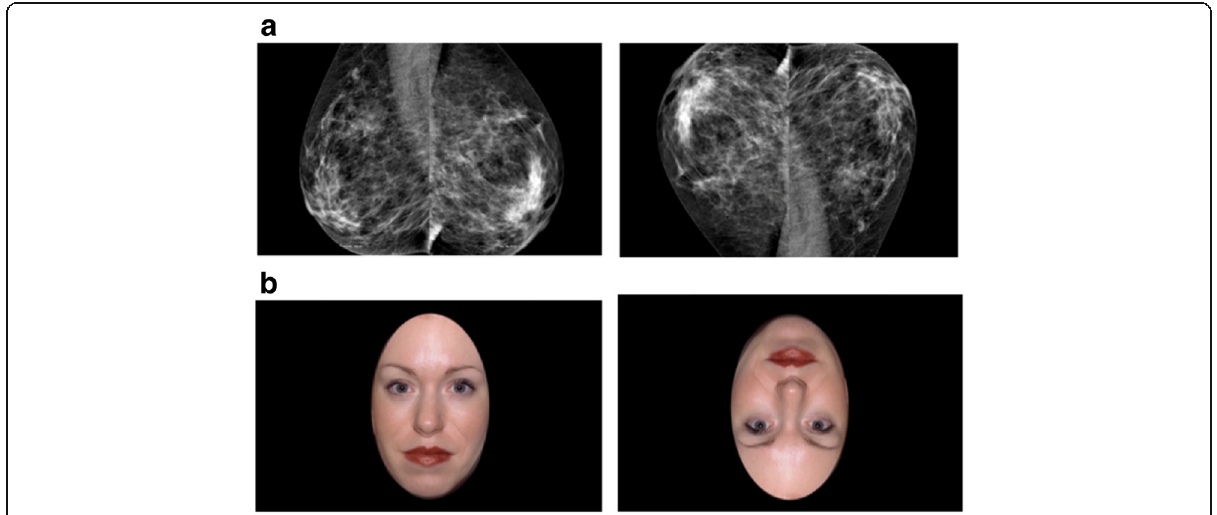
Fig. 1 Examples of mammogram and face stimuli in upright and inverted orientations. a Upright and inverted abnormal mammogram. b Upright and inverted smiling